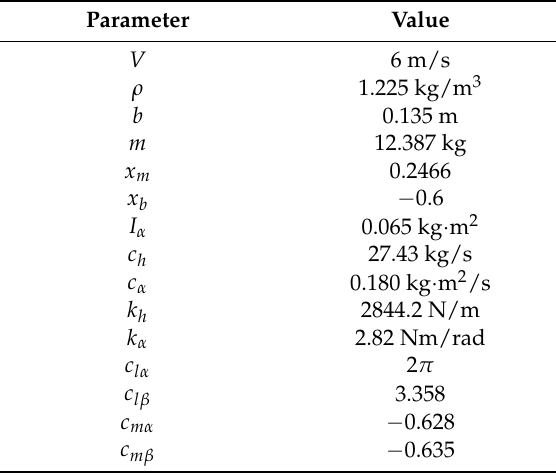
Table 1. Nonlinear aeroelastic system parameters.